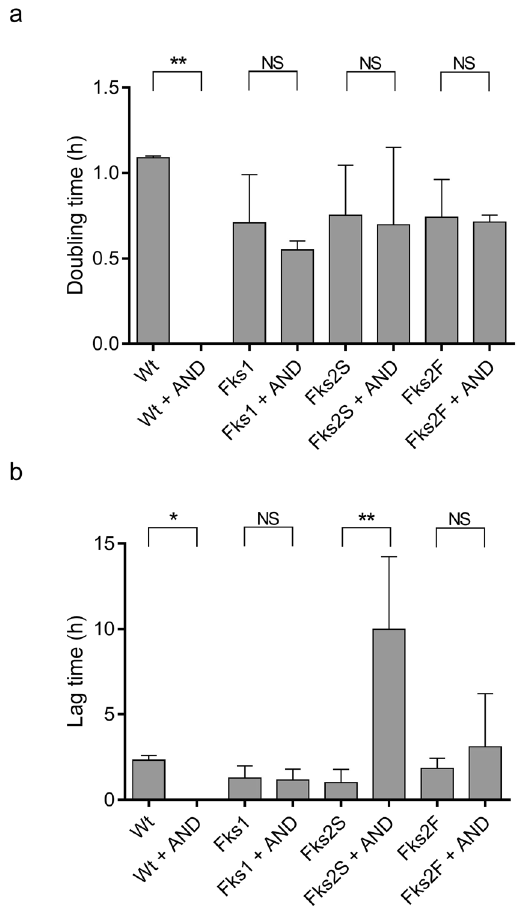
Figure 2. Cell growth parameters determined by an algorithm-based automatic calculation for C. glabrata isolates exposed to anidulafungin. A total of 24 isolates, 2 with WT FKS genes, 6 with NWT FKS1 genes and 16 with NWT FKS2 genes were compared. For each group, growth parameters were evaluated in the isolates exposed to 0.06- µ g/mL anidulafungin (AND) in comparison to the same isolates that were not exposed to the antifungal drug. Two subgroups of FKS2 -NWT fast and FKS2 -NWT slow isolates, i.e . identified within the FKS2 - NWT isolates based on marked differences in their cell growth profiles, were also compared. The cell doubling times (in h) are measured at the maximal growth rate. The lag times (in h) represent the mean ± SD of three independent growth curves of cells exposed at the same